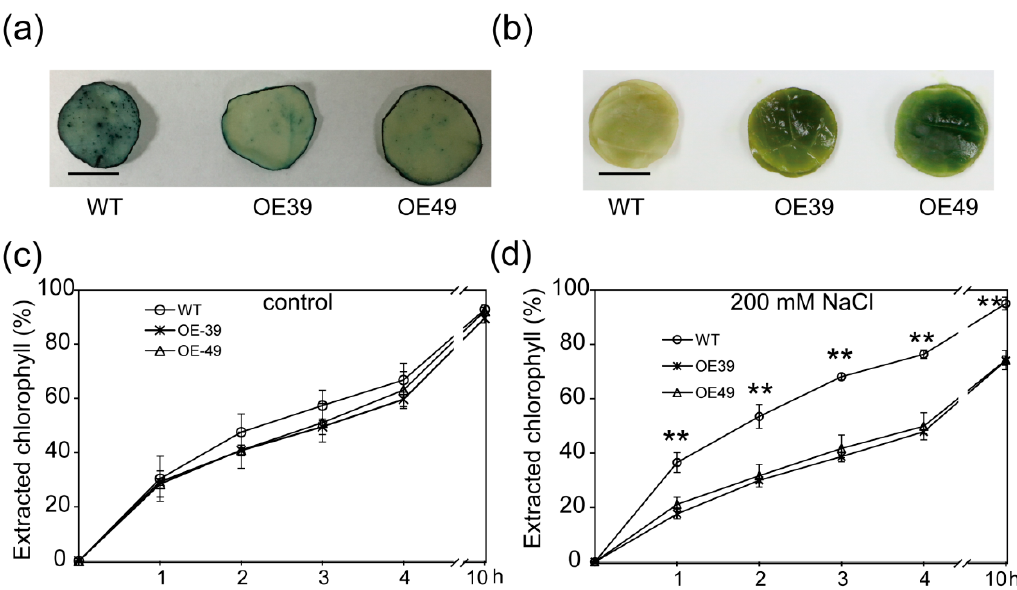
Figure 3. Overexpression of BnWIN1 reduced cuticular permeability under salt stress. ( a ) The reduced tubulin staining in BnWIN1 -OE plants under salt stress conditions. Scale bar = 1 cm. ( b – d ) The chlorophyll extraction rate of BnWIN1- OE and WT plants under control and salt stress conditions. Forty-day-old plants grown in soil in pots were treated without (control) or with 200 mM NaCl for 30 days. Values are mean ± SD ( n = 3 independent experiments). Scale bar = 1 cm. ** indicate significant difference at p < 0.01 compared to WT based on Student’s t test.